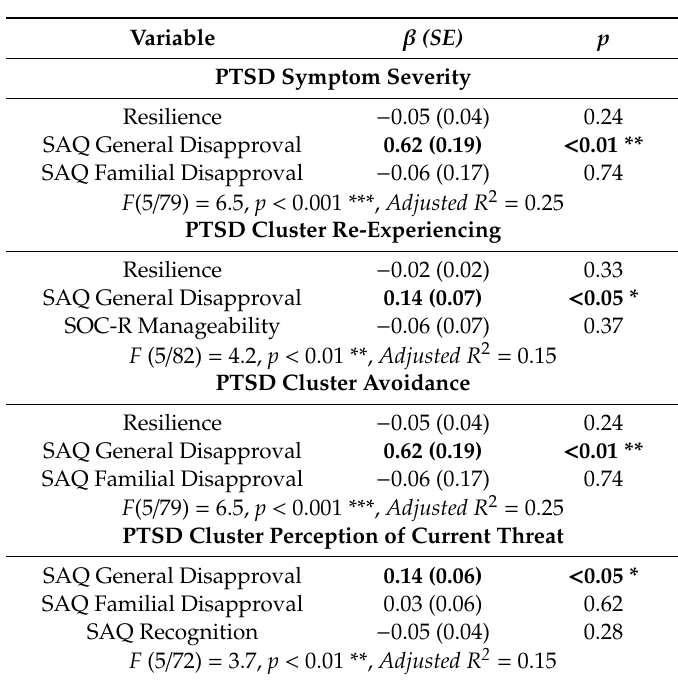
Table 1. Linear regression models investigating associations between predictor variables and PTSD symptom severity and symptom clusters.